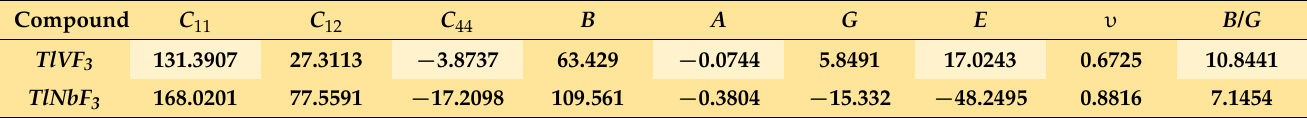
Table 2. The calculated elastic parameters C 11 , C 12 , C 44 , B, A, G, E (all in GPa), υ , and B/G of both the TlVF 3 and TlNbF 3 compounds. The table shows the cubic elastic constant C 11 , C 12 , C 44 and the